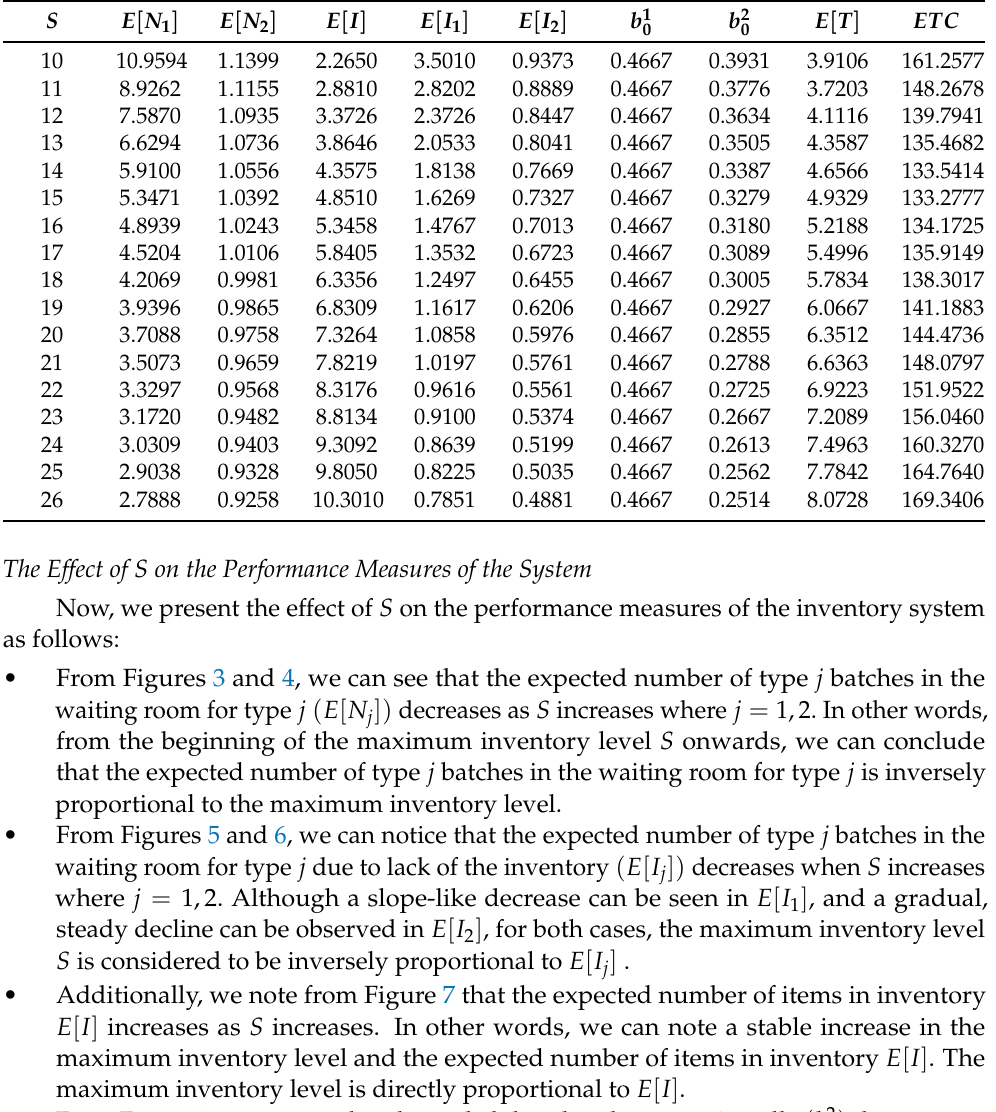
Table 4. Effect of S on various performance measures; the expected cycle length and the expected total